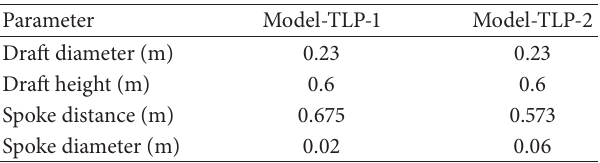
Table 3: Model-TLP